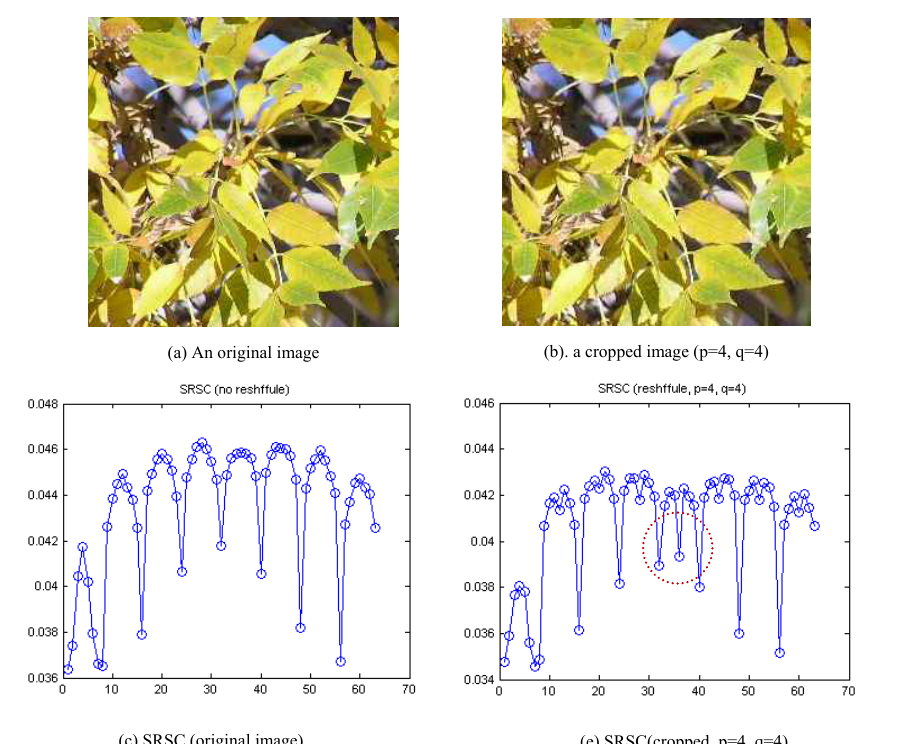
Figure 2. A comparison of SRSC features from an original JPEG image and three cropped JPEG images. X-label shows the SRSC feature index and y-label indicates the value